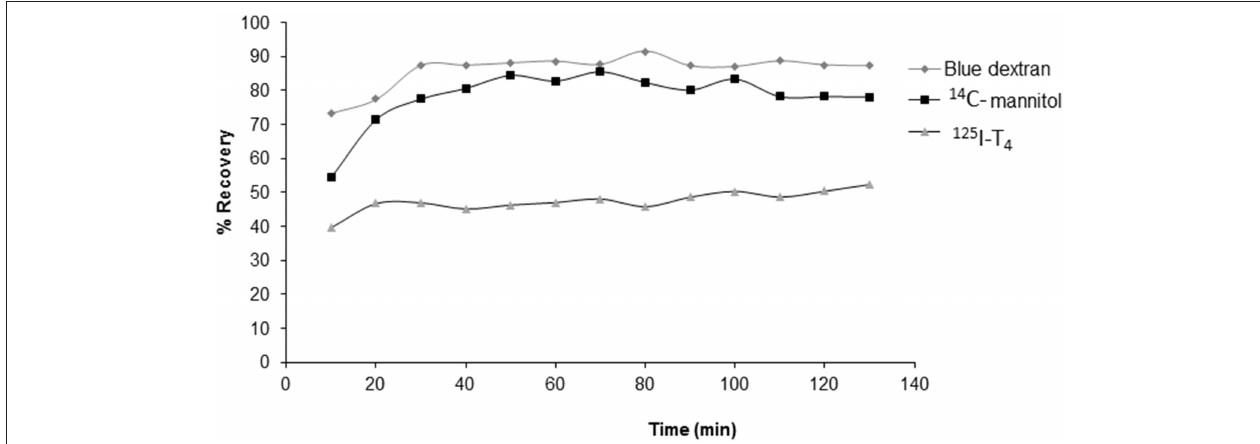
FIGURE 1 | A representative graph showing the recovery of blue dextran, 14 C-mannitol and 125 I-labeled T 4 in outflow aCSF during 2h of V-C perfusion in rabbits. Blue dextran was used as an indicator molecule for the newly secreted CSF under experimental conditions, whereas 14 C-mannitol was used as an extracellular marker. Data are presented as mean ± SEM of 13 samples taken at various time points, n = 5 rabbits for each condition.